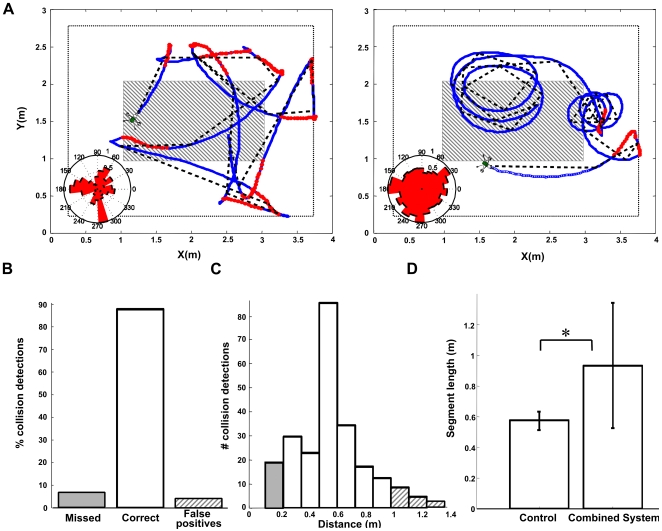
Trajectories and behavioural analysis of the “Strider” robot controlled by our LGMD model and a fly EMD based course stabilization system.(A) Representative traces of the behaviour of the robot. Left panel shows the behaviour of the robot controlled by the LGMD model in combination with an EMD-based course stabilization system, as in [37]. Right panel shows the behaviour in absence of course stabilization. The blue traces indicate the position of the robot and the red segments indicate the detection of imminent collisions. The black dashed lines are obtained by fitting linear segments to the robot traces, minimizing the Mean Square Error (MSE). Inserted into both panels are polar plots of the heading direction. (B) Collision detections between 20cm and 100cm away from the wall were classified as correct, those detected closer than 20cm from the wall (solid gray area in A) as missed, and collisions detected at a distance over 100cm as false positives (dashed area in A). (C) Detected collisions vs. distance. Bar colors correspond to the classification of the collision detection defined in panel B. (D) Segment length: Histogram of the length of the linear segments identified with the fitting procedure in (A). This measures the straightness of the traces of the robot in the control situation and when controlled by the combined course stabilization and collision avoidance system. The error bars indicate data variance. The data in (B) and (C) corresponds to 16 experiments with the combined course stabilization and collision avoidance system and 5 control experiments (LGMD alone) in (D).